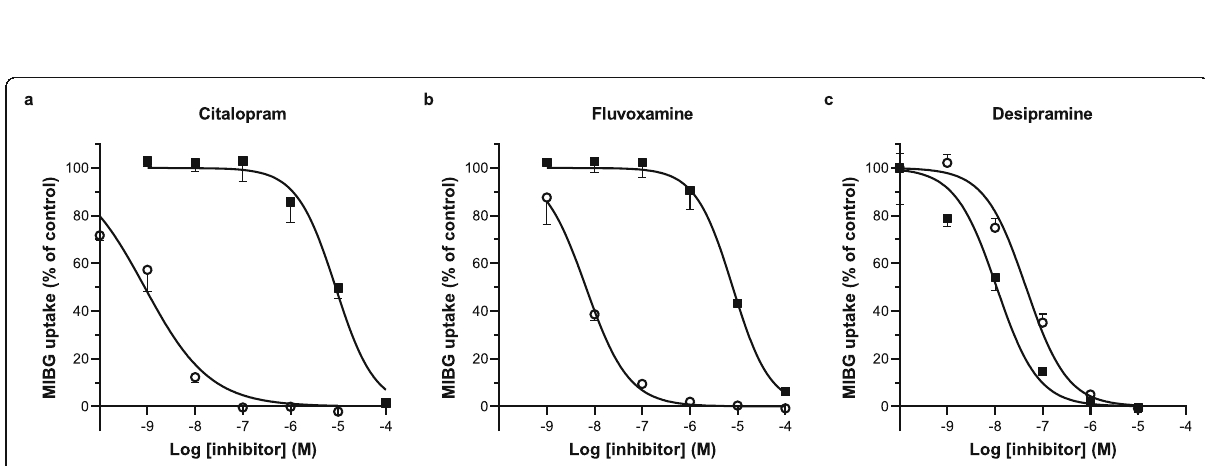
Fig. 3 Inhibition of [ 125 I]MIBG uptake in SERT- and NET-transfected HEK293 cells by SSRIs and desipramine. MIBG uptake assays were performed on HEK-SERT cells (open symbols ○ ) or HEK-NET cells (closed symbols ■ ) in the presence of various concentrations of citalopram ( a ), fluvoxamine ( b ), and desipramine ( c ). [ 125 I]MIBG uptake is expressed relative to assays conducted in the absence of inhibitors. Cells were incubated for 1 h with a substrate concentration of 10 − 6 M. Data represent mean ± SD ( n =